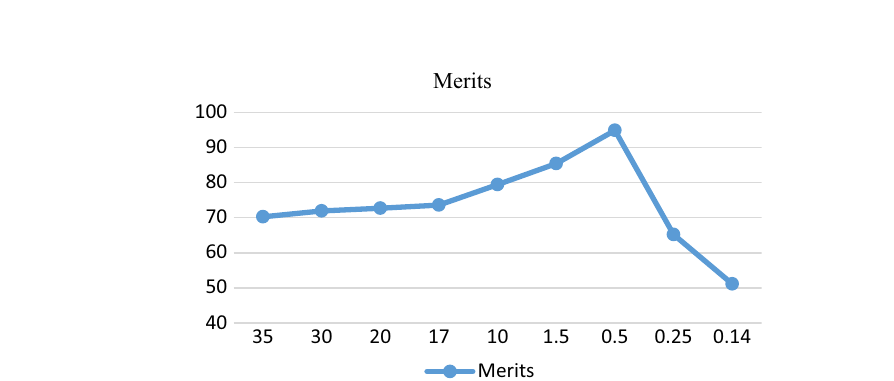
Fig. 8 The change in the merits concerning the change in the parameter p on the proposed data